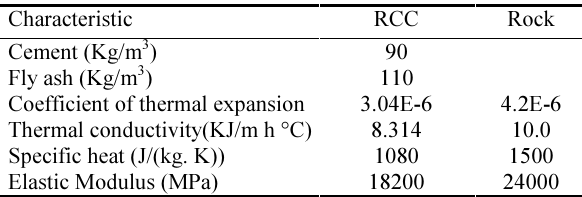
Fig. 3. Monthly air temperature at project site